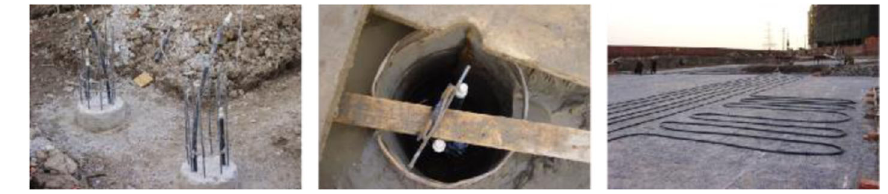
Fig. 9 Buried pipe forms. a Pile; b Vertical; c Horizontal